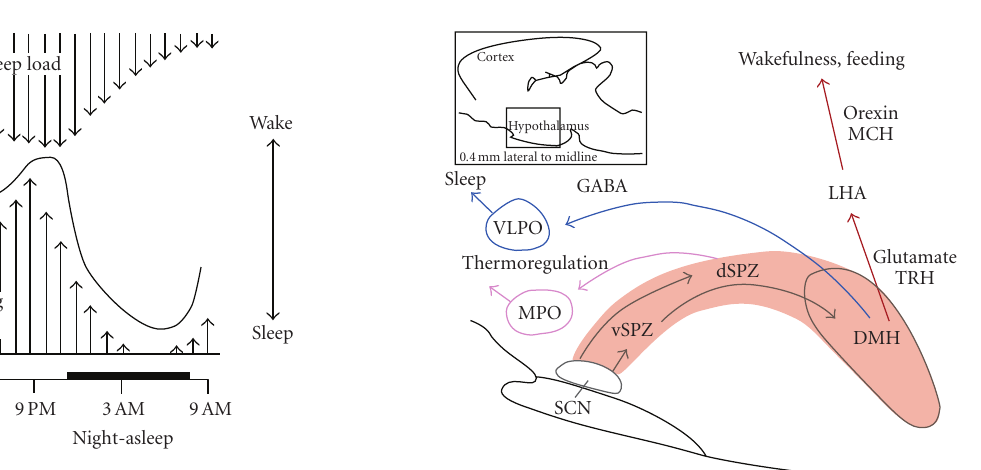
Figure 2: Pathways involved in the hypothalamic control of the circadian rhythms of sleep, wakefulness and body temperature. In the regulation of circadian sleep-wake patterns, outputs from the SCN relay at the vSPZ, and project to the DMH. The DMH then sends outputs to the VLPO (a sleep-activating center), and the LHA (where orexin neurons target downstream wake-promoting sites). The SCN regulates circadian body temperature rhythms through a relay at the dSPZ, which projects to the MPO. SCN, suprachiasmatic nucleus; vSPZ: ventral subparaventricular zone; dSPZ: dorsal subparaventricular zone; DMH: dorsomedial nucleus; VLPO: ventrolateral preoptic nucleus; LHA: lateral hypothalamic area; MPO: medial preoptic nucleus; MCH: melanin-concentrating hormone; TRH: thyrotropin-releasing hormone. Modified with permission from